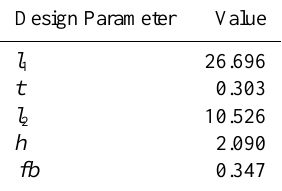
Table 5. Design parameters obtained after optimization (unit: mm).